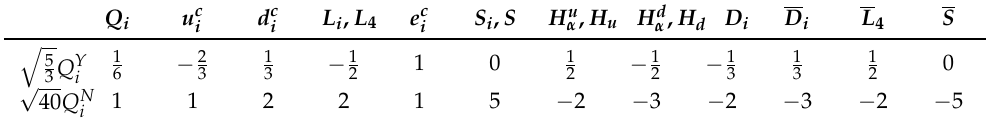
Table 1. The U ( 1 ) N and U ( 1 ) Y charges of matter supermultiplets in the SE 6